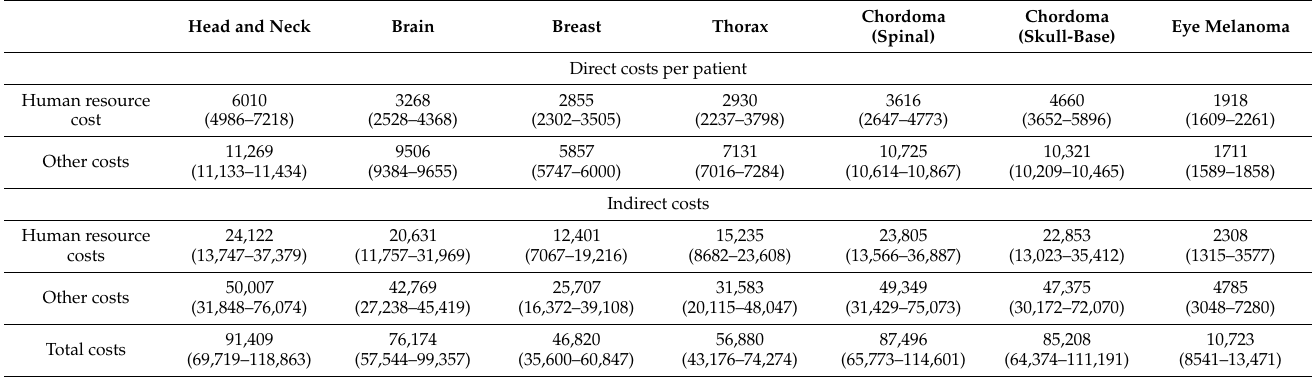
Table 4. Probabilistic sensitivity analysis of the cost per patient per indication based on scheme 1 (Mean (range)).